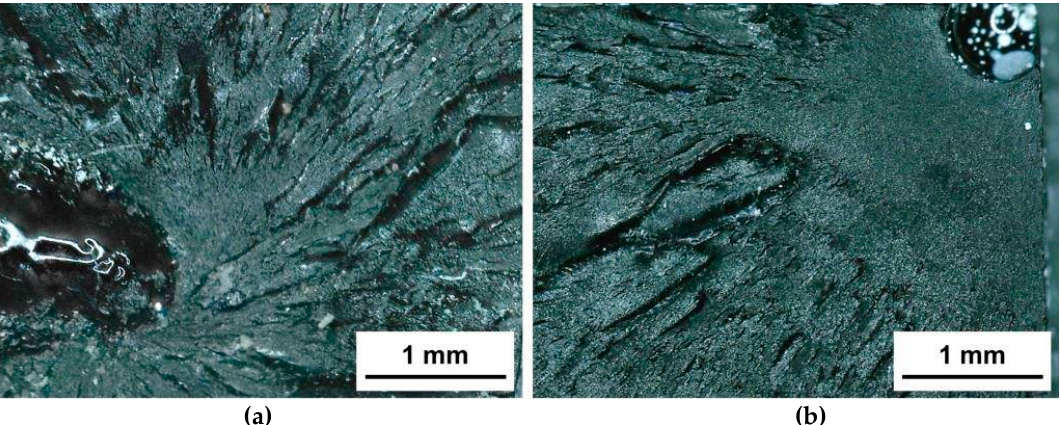
Figure 3. Optical light microscope images of the fracture surface of porous tensile specimens: Initiation of the crack due to an air bubble ( a ) in the inside of a specimen and ( b ) at the surface of the specimen.